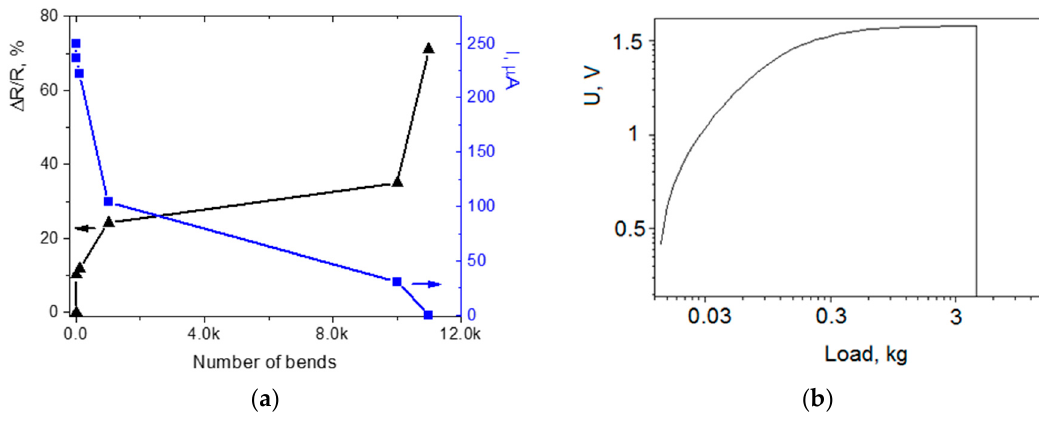
Figure 7. ( a ) Change of the current flow through the multilayer structure and the electrode sheet resistance as a function of the number of bends at a constant frequency of 10 Hz, and ( b ) relation between the voltage generated and the weight at static load.